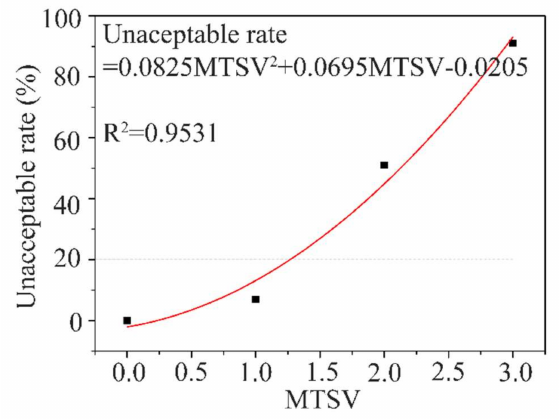
Figure 8. Thermal comfort